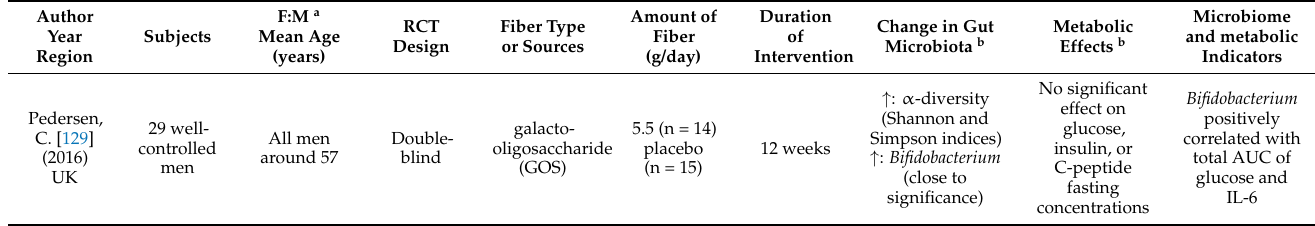
Table 3. Modulation of dietary fiber on gut microbiota and metabolic outcomes in patients with type 2